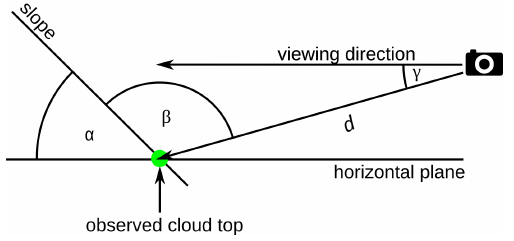
Figure 12. Definitions used in Eqs. (6) and (7).